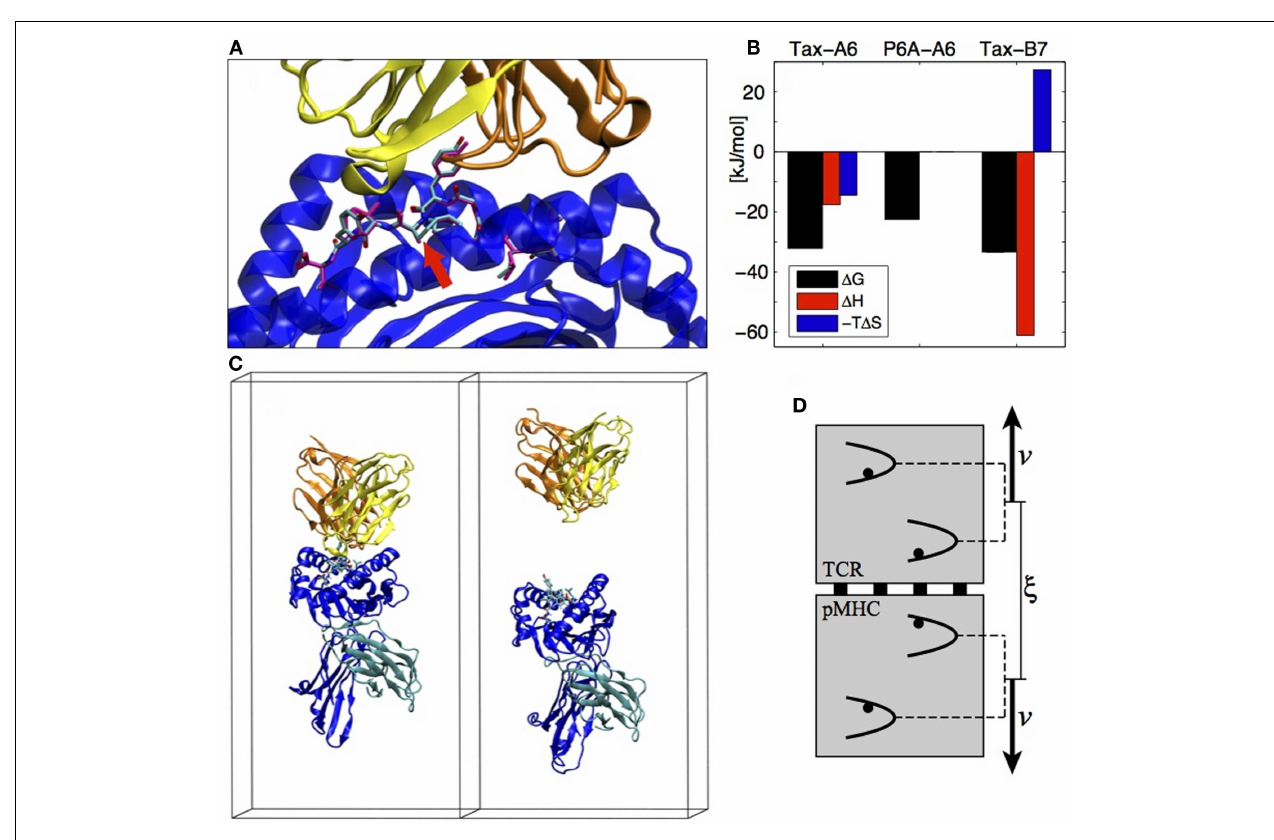
and after the SMD simulation (water molecules not shown). (D) The individual pulling scheme used to dissociate the proteins.The distance ξ between the centers of mass is increased at rate 2 v . Each backbone heavy atom is subjected to an individual harmonic potential. All individual potentials move in concert, with their relative positions fixed to their values in the crystal